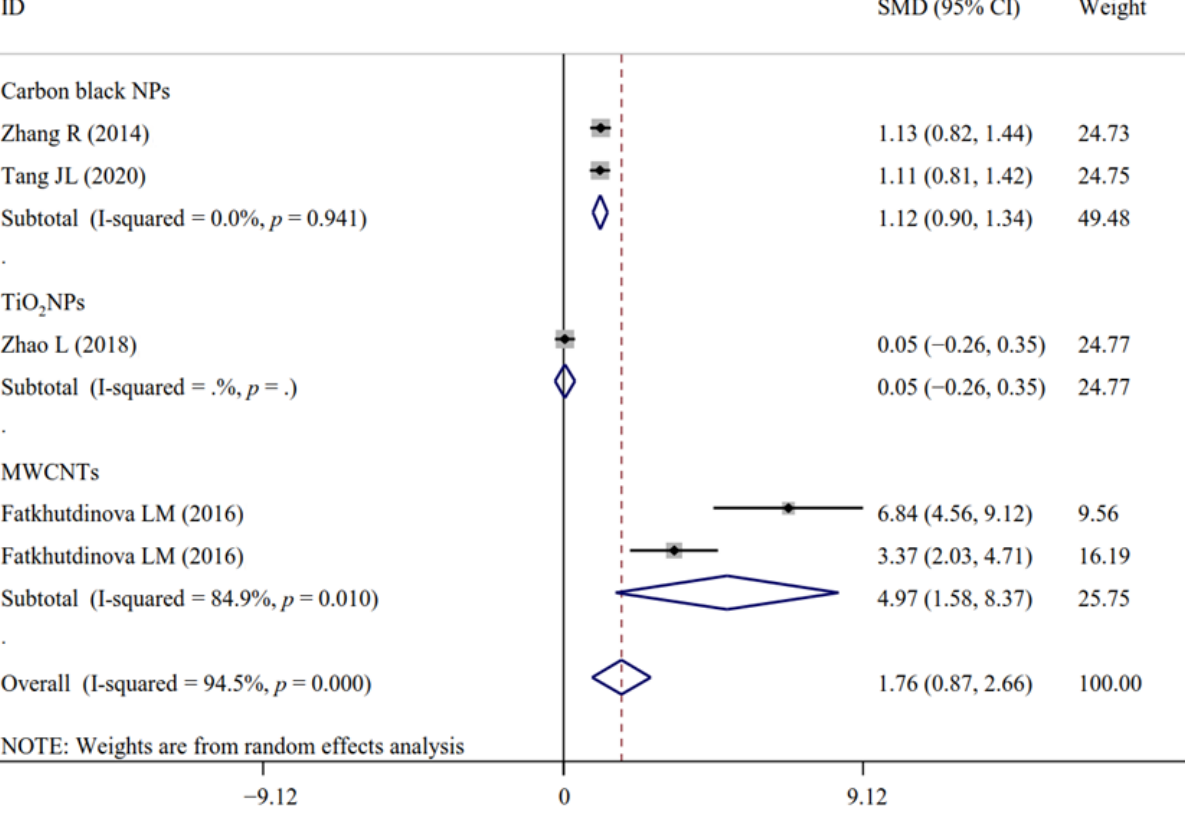
Figure 8. Forest plots assessing the effects of exposure to different NMs on the level of IL-1 β compared with the non-exposed control group. NMs, nanomaterials; NPs, nanoparticles; TiO 2 NPs, titanium dioxide nanoparticles; MWCNTs, multi-walled carbon nanotubes; IL-1 β , interleukin-1 β ; SMD, standardized mean difference; CI, confidence interval [17,19,39,40].